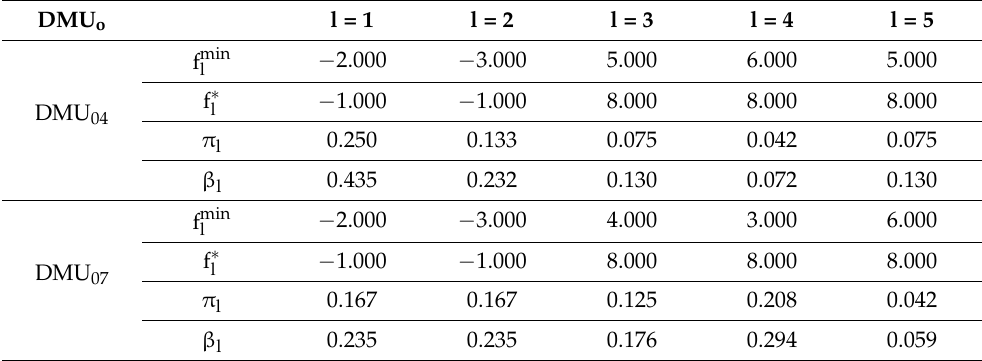
Table A3. Calculating parameters for three DMUs to compose model 14 of step 1 of STEM (p = 1) in the second case